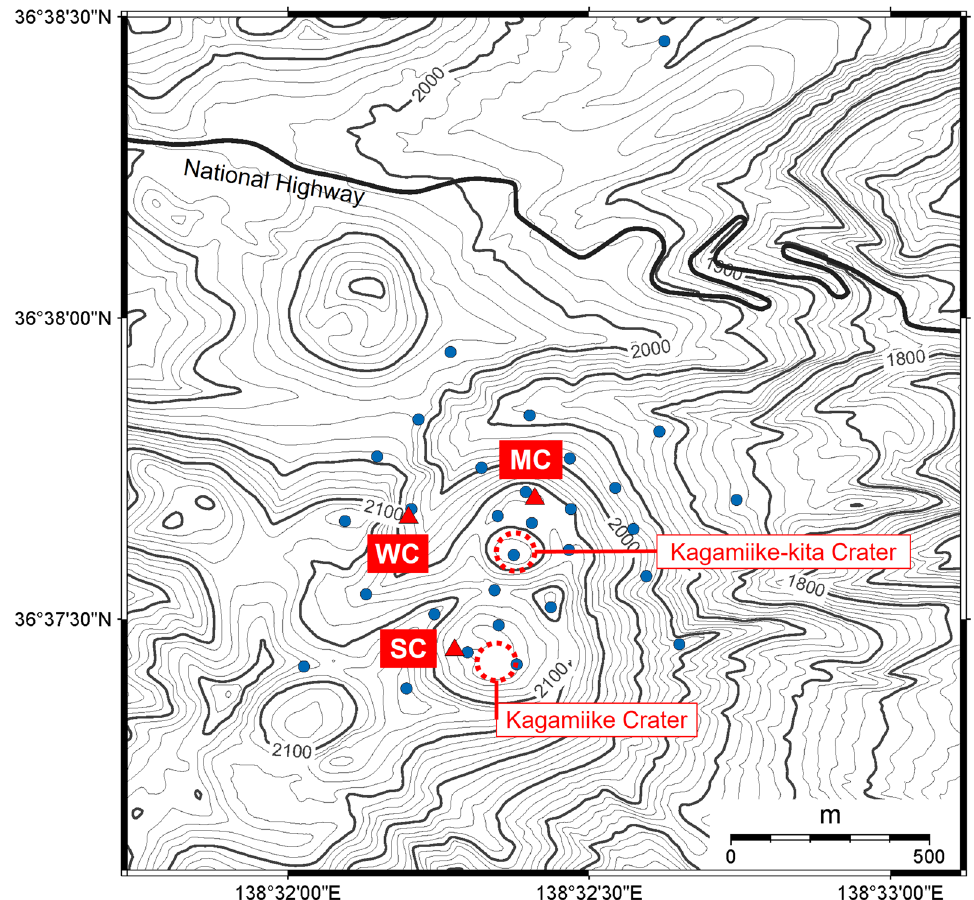
Fig. 2 Topographical map showing the survey area. Blue dots show the AMT sites. The three red triangles represent the craters of the 2018 eruption (MC Main Crater, WC West Crater, and SC South Crater). Red dotted circles represent two pre-existing craters (Kagamiike-kita Crater and = = = Kagamiike Crater) of Mt. Motoshirane. The black solid line indicates a national